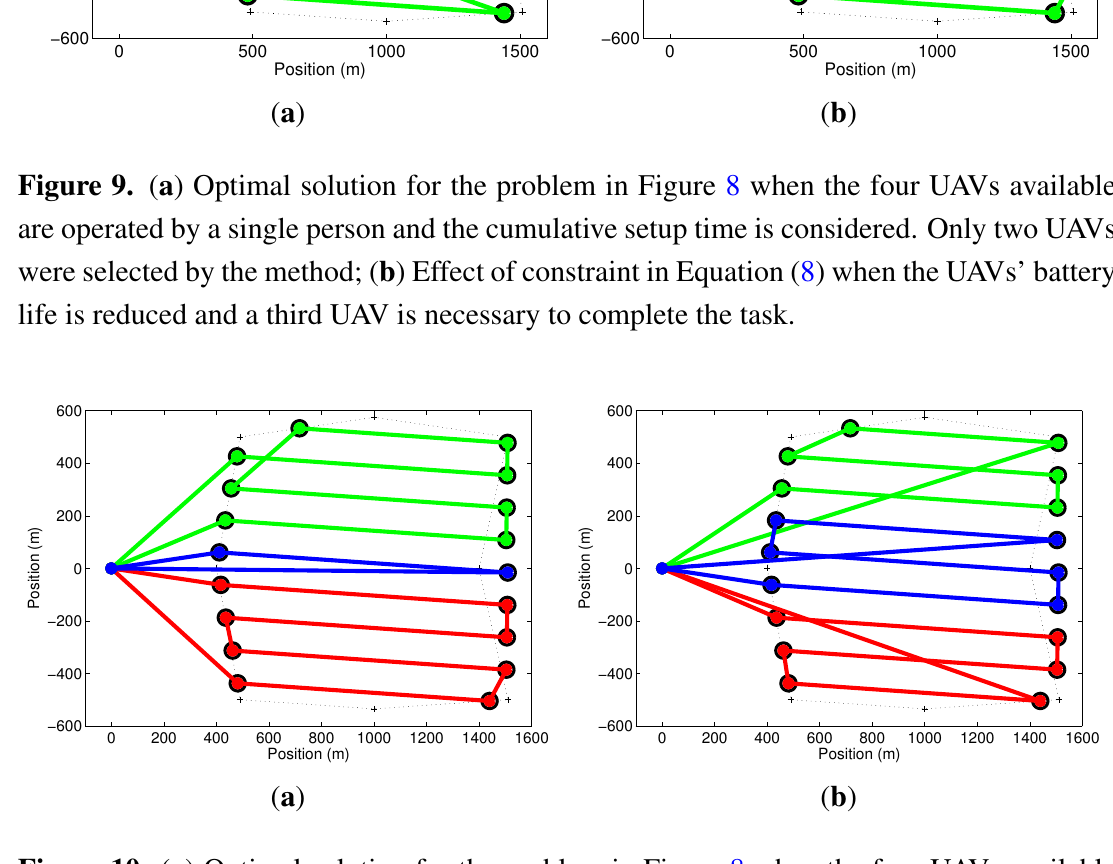
Figure 10. ( a ) Optimal solution for the problem in Figure 8 when the four UAVs available are operated by a team of two operators. Only three UAVs were selected by the